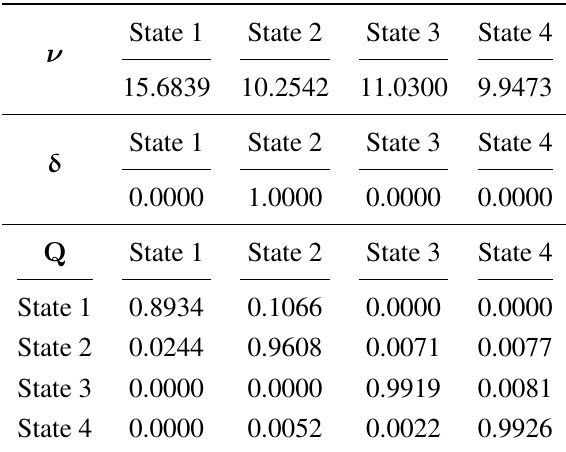
Table 4. Maximum likelihood estimates of the degrees of freedom (cid:23) , the initial probability (cid:14) and the transition probability matrix Q of the Markov chain for the selected Student- t MS model with four